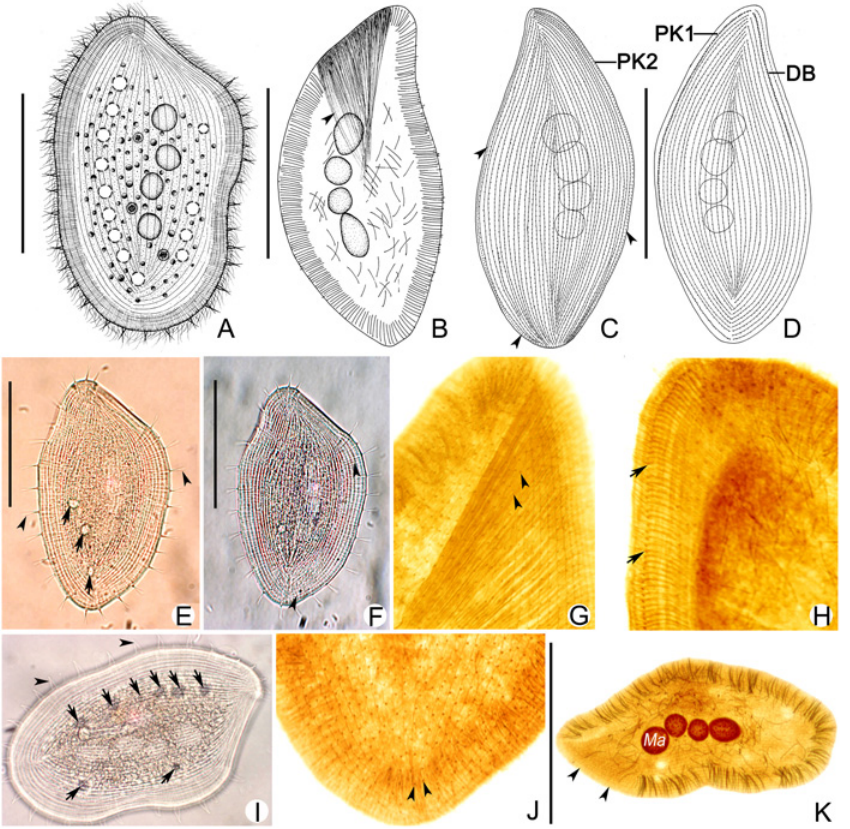
Fig 2. Kentrophyllum bispinum sp. n.; living individual (A-D, E, F, I) and cells stained with protargol (G, H, J, K). A. Right lateral view of representative specimen. B. Distribution of extrusomes and developed nematodesmata (arrowhead). C, D. Ciliary patterns of right (C) and left (D) side; arrowheads, perioral kinety 2. E, I. Right lateral view. Arrows, contractile vacuoles; arrowheads, double-spines. F. Right lateral view, showing the extrusomes (arrowheads). G. Anterior part of right side, showing the anterior suture (arrowheads). H. Anterior part of right side; arrows indicate the perioral kinety 1. J. Posterior part of left side showing the posterior suture (arrowheads). K. Distribution of extrusomes; arrowheads, oral slit. Ma, macronuclear nodules; DB, dorsal brush; PK1, perioral kinety 1; PK2, perioral kinety 2. Scale bars, 100 μ